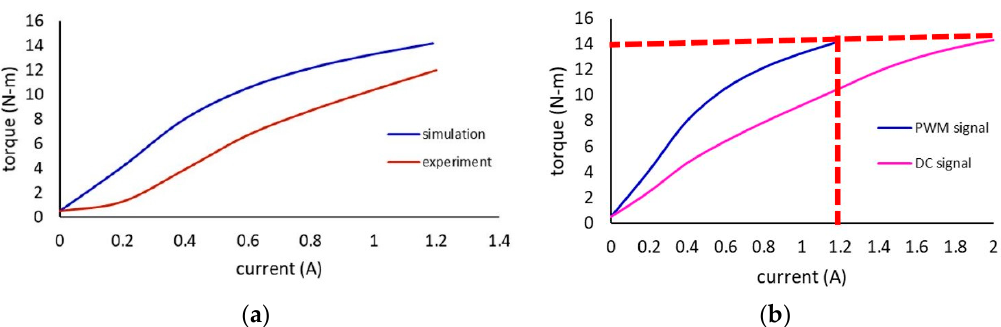
Figure 10. Torque performance of MR brake ( a ) Simulation and Experimental torque of MRB with PWM signal at 60% duty cycle ( b ) torque comparison of MR brake with PWM and DC signal.